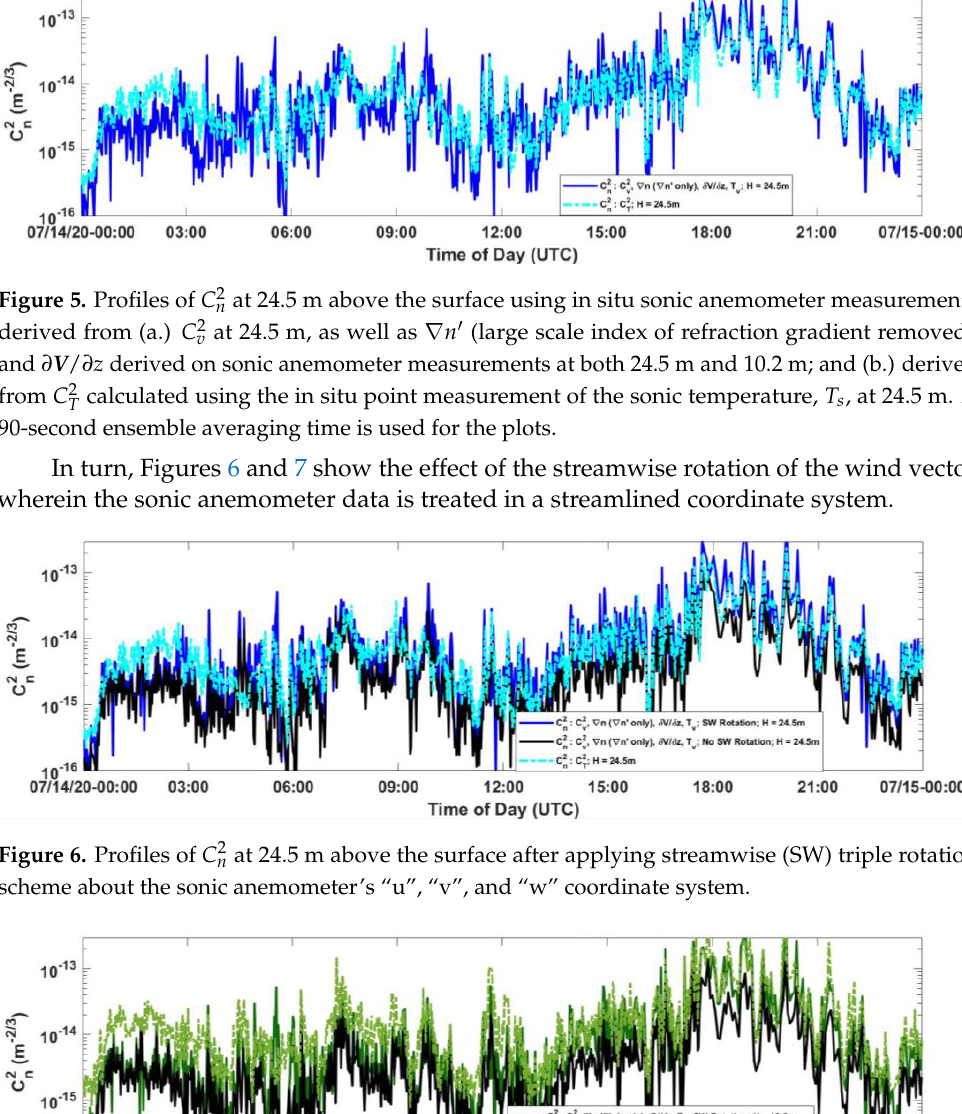
to topographical inhomogeneities at the lower height.